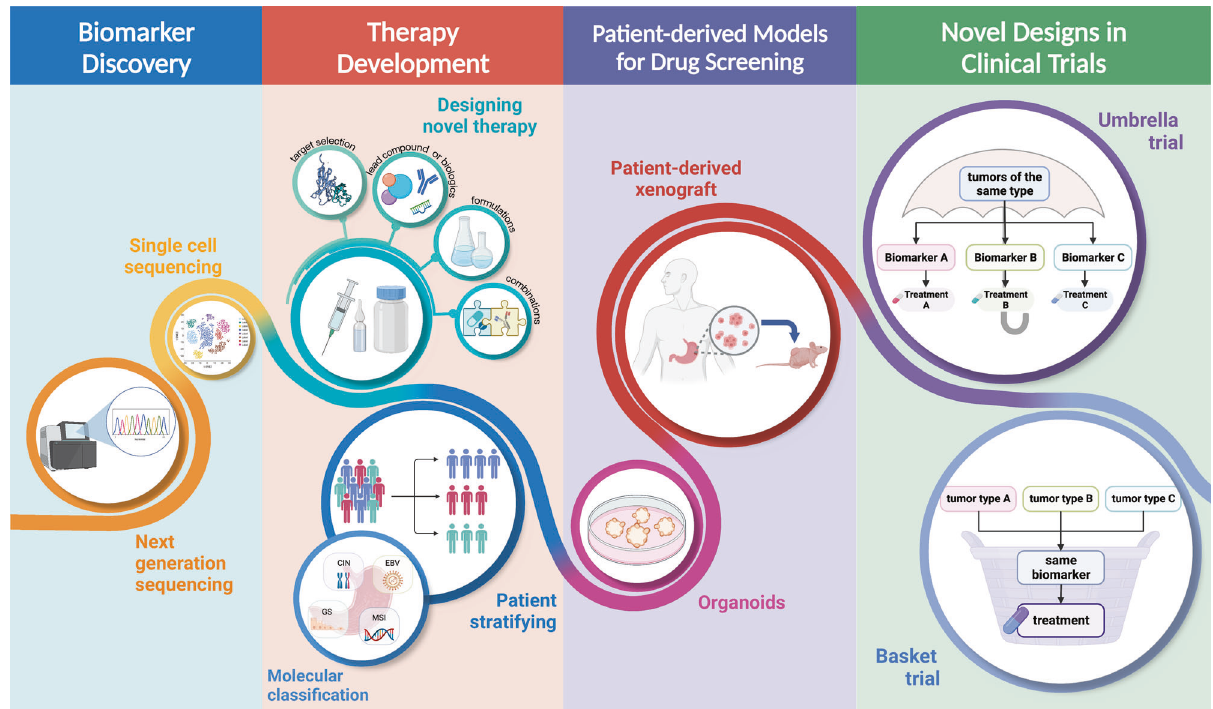
Fig. 6 Essential technologies and processes for elevating biomarker-guided precision medicine. The next-generation sequencing and novel technologies like single cell sequencing for pro fi ling genetic changes enable biomarker identi fi cation with higher precision. Biomarkers are the basis for molecular classi fi cation and patient stratifying. Meanwhile, biomarker-based novel therapy is developed as the target is selected. New therapeutic agents are developed with lead compound or biologics identi fi ed, followed by formulation optimization and possible combination designs. The patient-derived xenograft or organoid research models are useful tools for drug screening and molecular mechanism veri fi cations. Finally, novel clinical trial designs like umbrella trials and basket trials enable precise evaluation of treatment effects under a fi ne strati fi cation of patients. This fi gure was drafted with Biorender.com and modi fi ed using Adobe